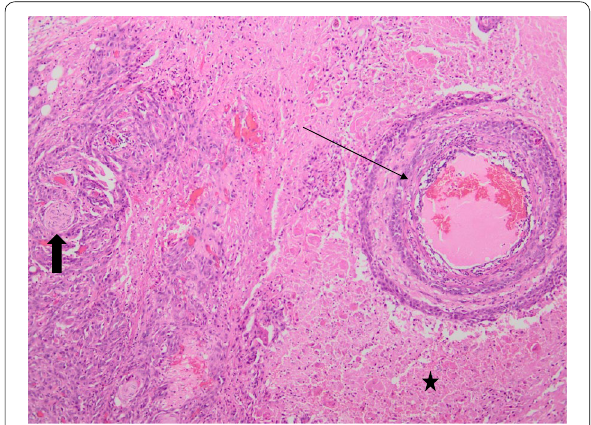
Fig. 4 Haematoxylin and eosin (H&E) photomicrograph demonstrating perineural invasion (block arrow), necrosis (star), and lymphovascular invasion (thin arrow) (original magnification